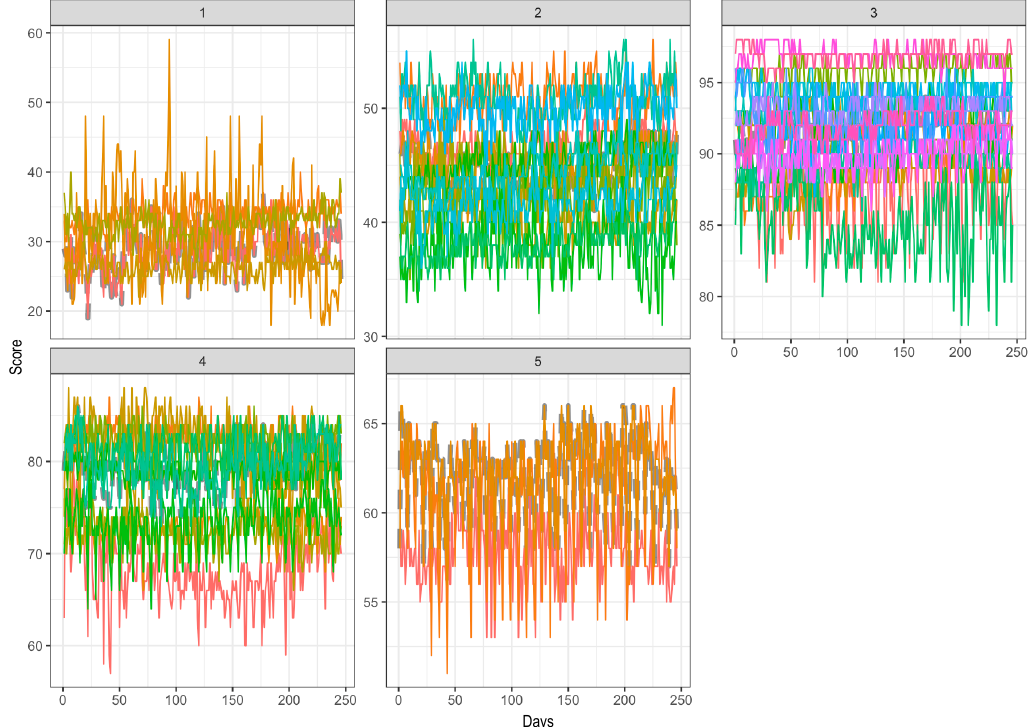
Figure 4. The time series of the commune mobility scores that belong to the five cluster solution. ( 1 ) Cluster 1 ; ( 2 ) Cluster 2 ; ( 3 ) Cluster 3 ; ( 4 ) Cluster 4 ; ( 5 ) Cluster 5